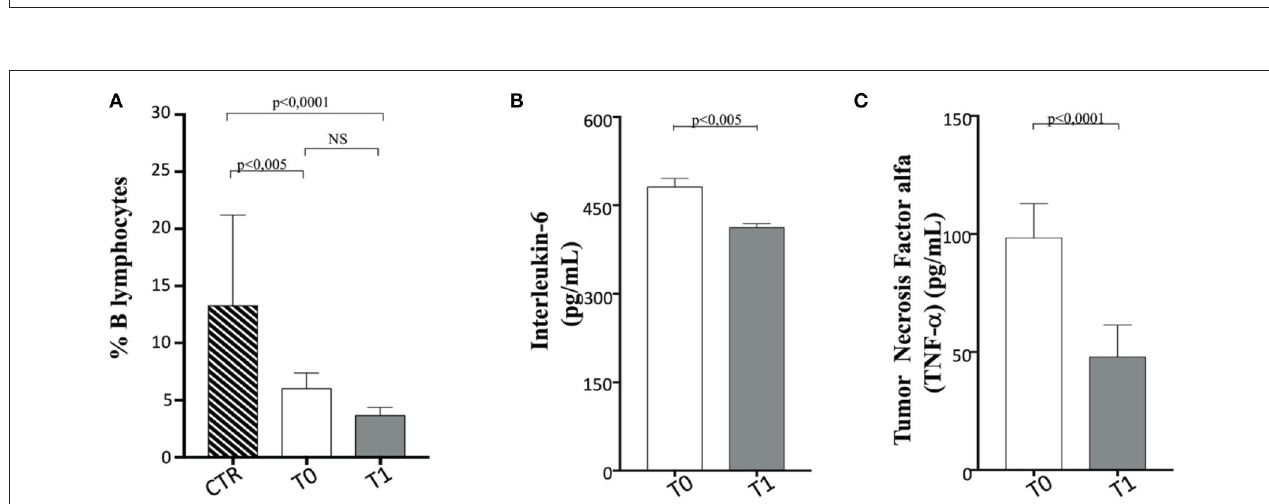
FIGURE 9 | B cells, interleukin (IL)-6, and tumor necrosis factor (TNF)- α in enrolled dogs. (A) Evaluation of B cell percentage in obese dogs, at T0 (white column) and T1 (gray column) and control (CTR) (dashed column) subjects, as indicated. (B,C) Amplitude of IL-6 and TNF-a production, respectively, in obese dogs at T0 (white column) and T1 (gray column). Values are in pg/ml. Statistics: Wilcoxon matched-pairs signed-rank test was used for T0 and T1 comparation in obese dogs, while Mann–Whitney test was performed for the comparation between T0 obese and CTR group subjects. NS means not significant difference.